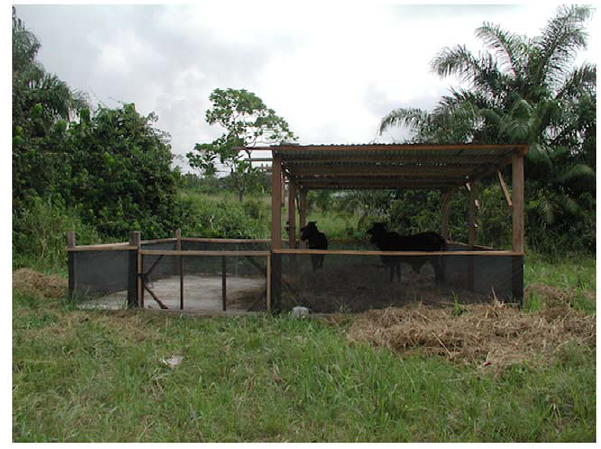
Figure 1. Experimental animal enclosure at Boadi Cattle Research Farm,